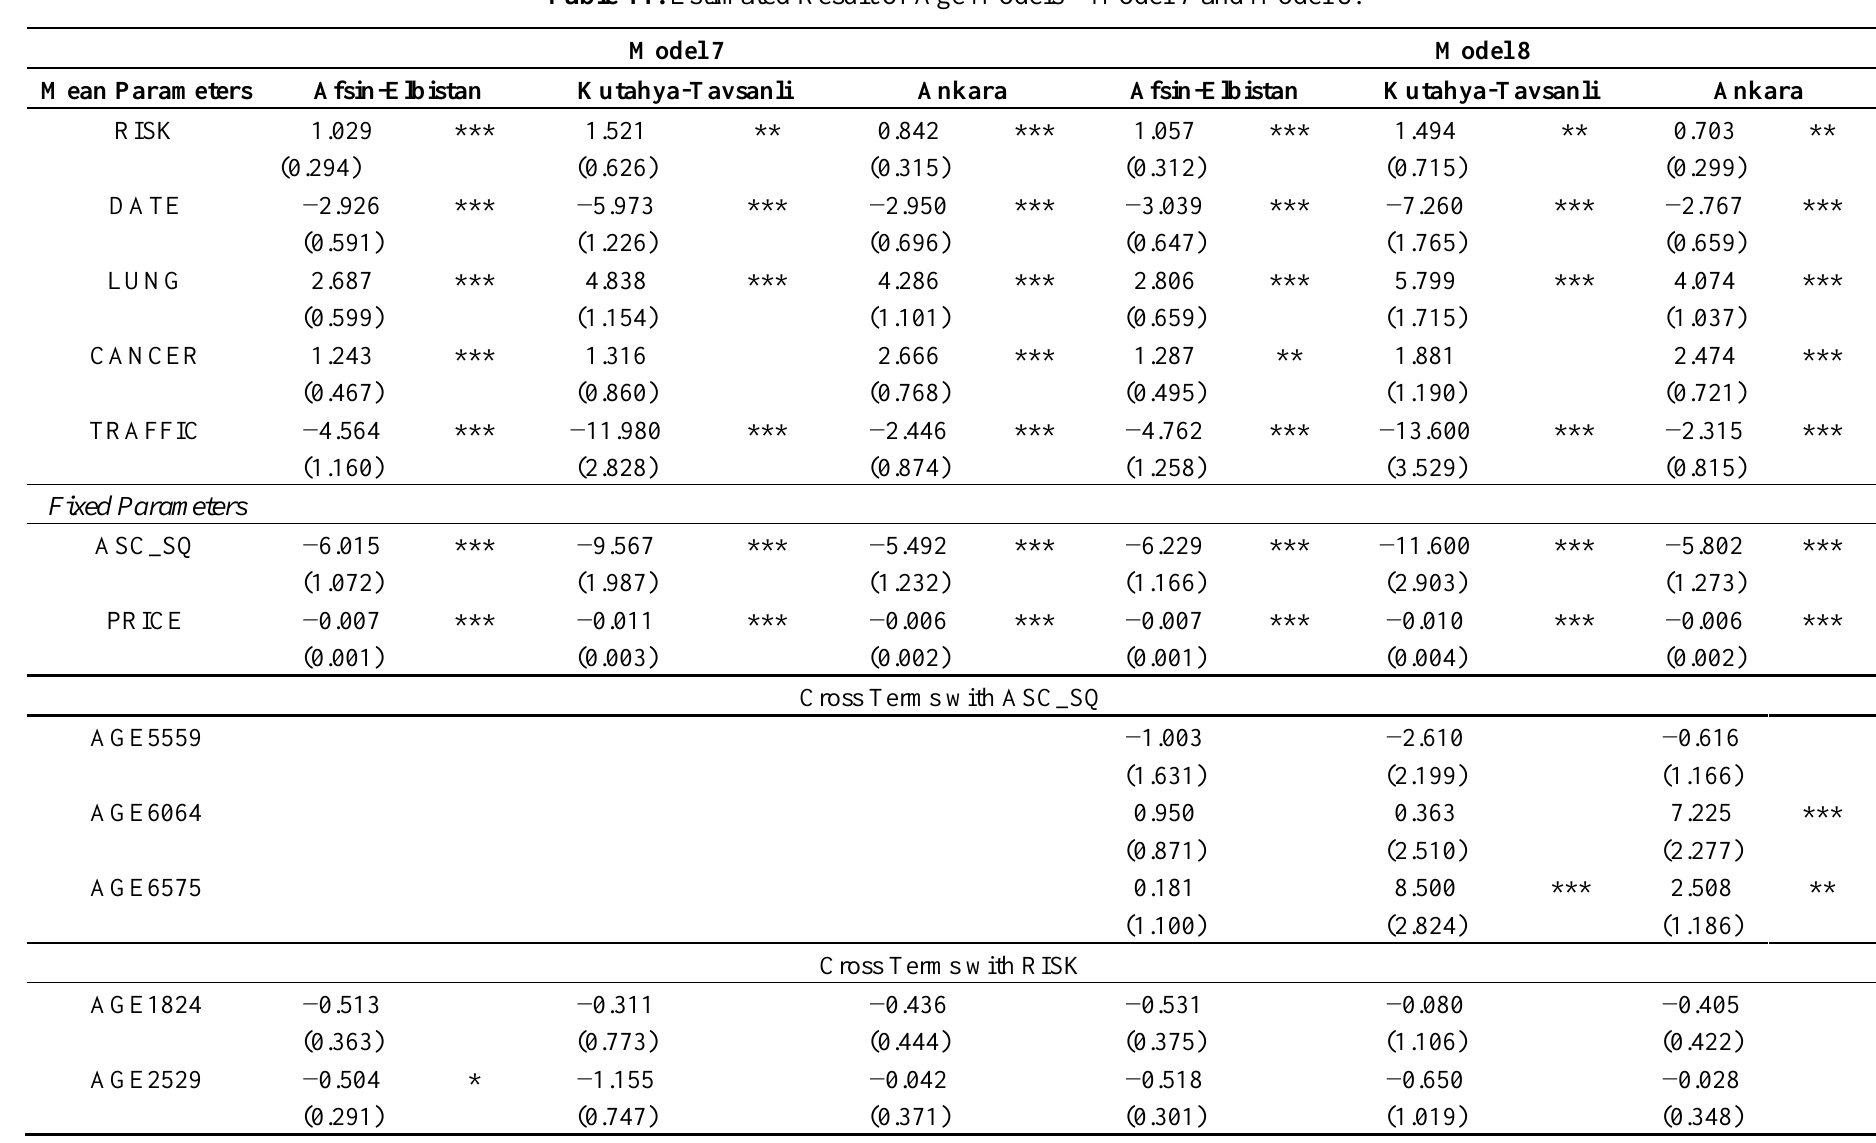
Table 11. Estimated Result of Age Models—Model 7 and Model